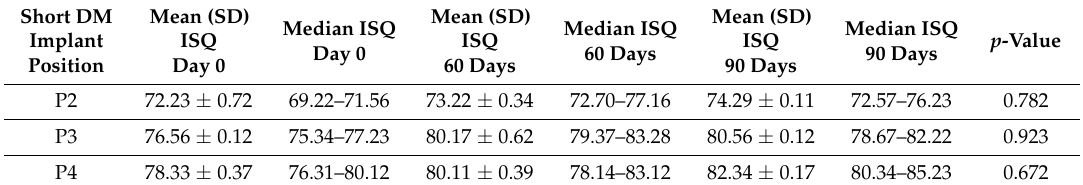
Table 2. Implant Stability Quotient (ISQ) mean values at 0 days, 60 days, and at 90 days of the extra-short wide ring implants.